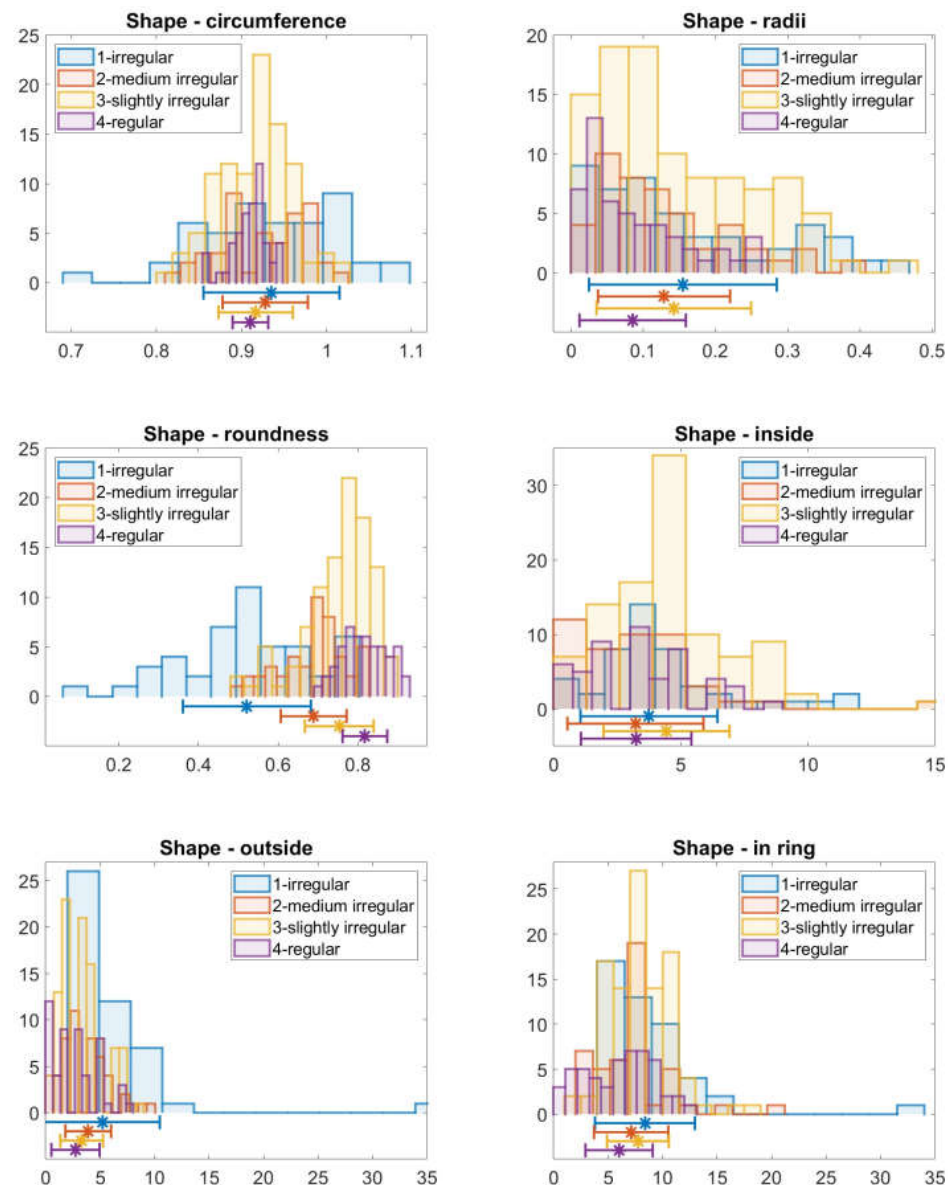
Figure 7. Expert opinion vs. computer calculated shape regularity values. The expert categories are represented by different colors, the machine calculated quantities are on the horizontal axis. The histograms of the machine calculated values corresponding to images from the four experts’ categories are plotted in the upper half of the images, while the mean value and standard deviation are denoted by a marker * and an interval around the mean value at the bottom of the plot, with the same color as the histogram.